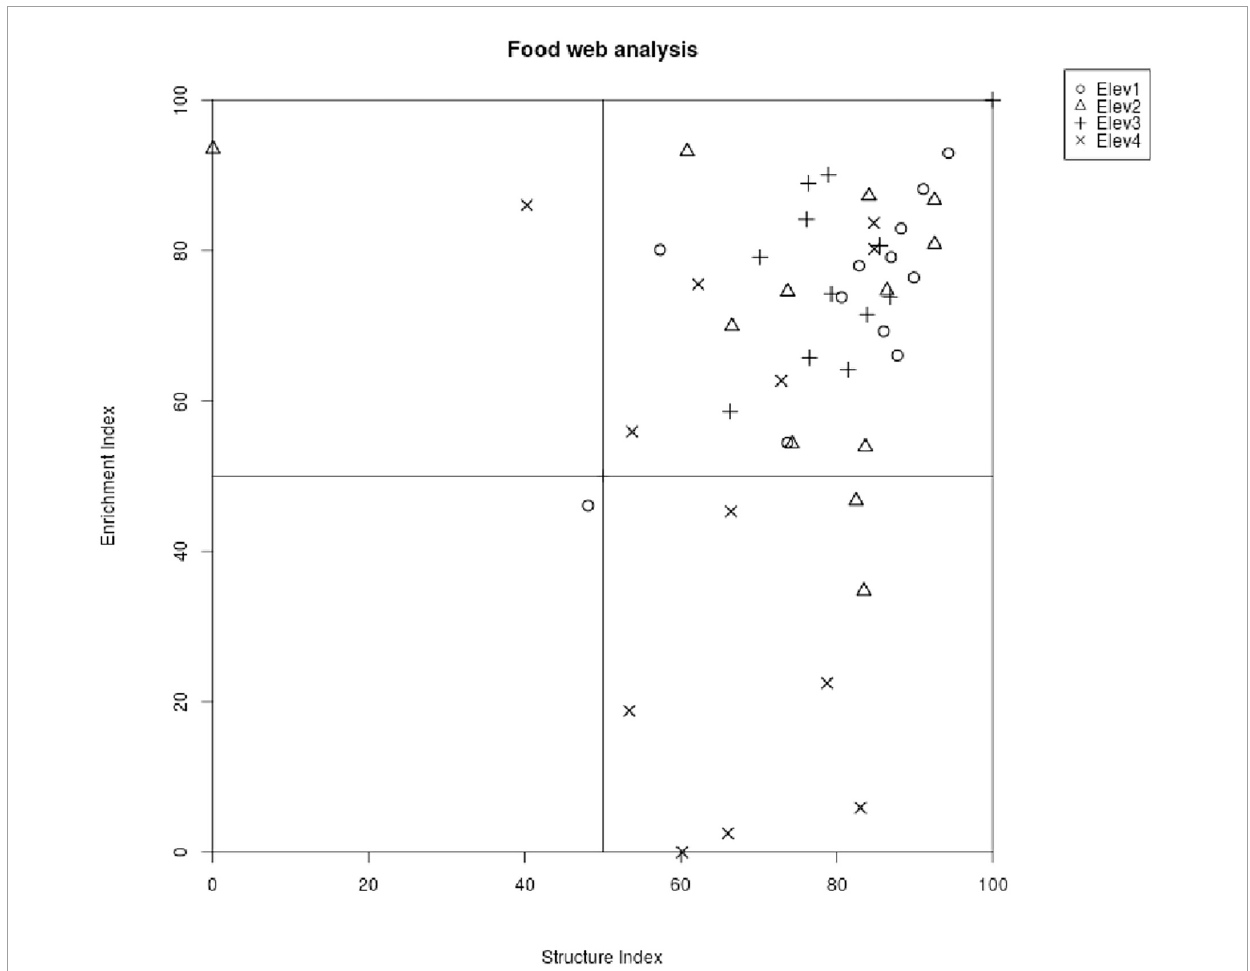
FIGURE4 Food web diagnostic profile across the studied elevational classes. Elev, elevation; where Elev1: 1,000–1,400 m, Elev2: 1,401–1,800 m, Elev3: 1,801–2,200 m, and Elev4: 2,201–2,600